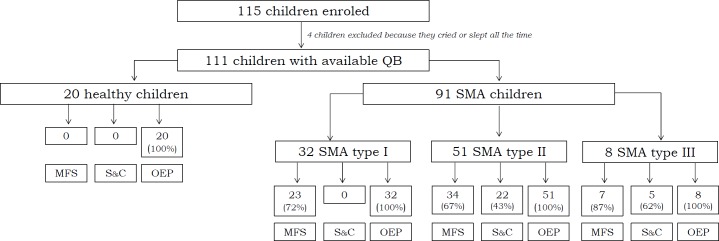
Flow diagram of recruited children and functional tests.QB: quiet breathing; MFS: motor functional scale; S&C: spirometry and cough tests; OEP: opto-electronic plethysmography